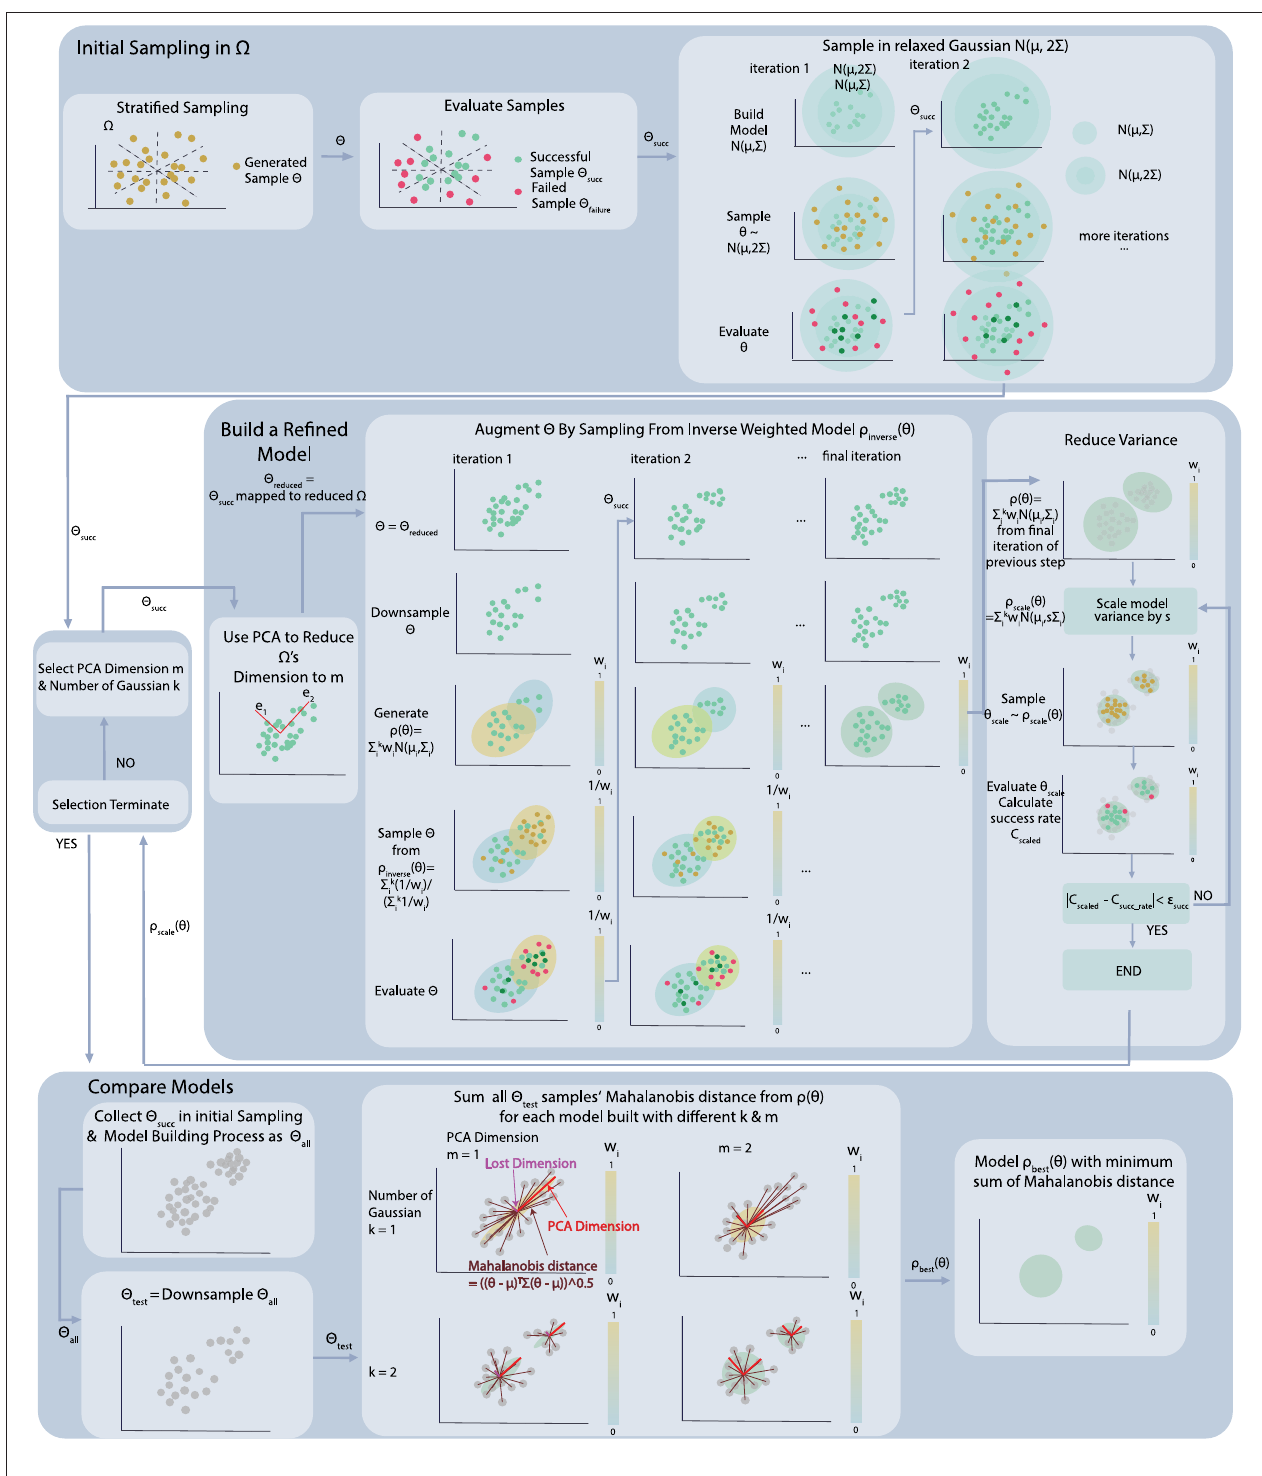
FIGURE 2 | Algorithm flow